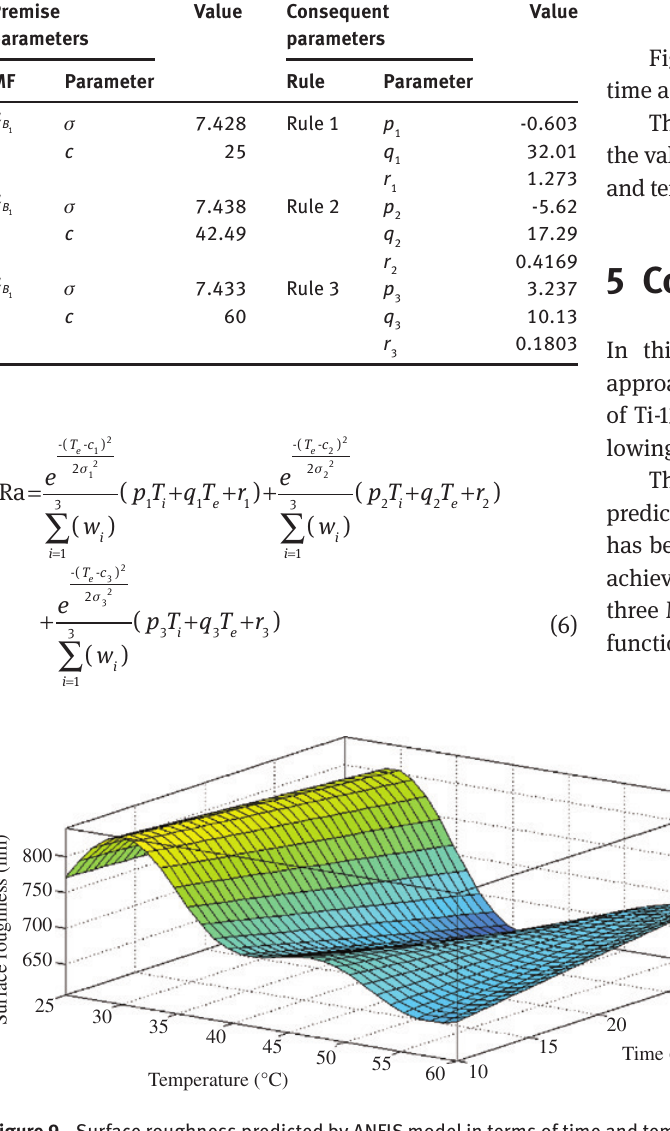
Figure 9 Surface roughness predicted by ANFIS model in terms of time and